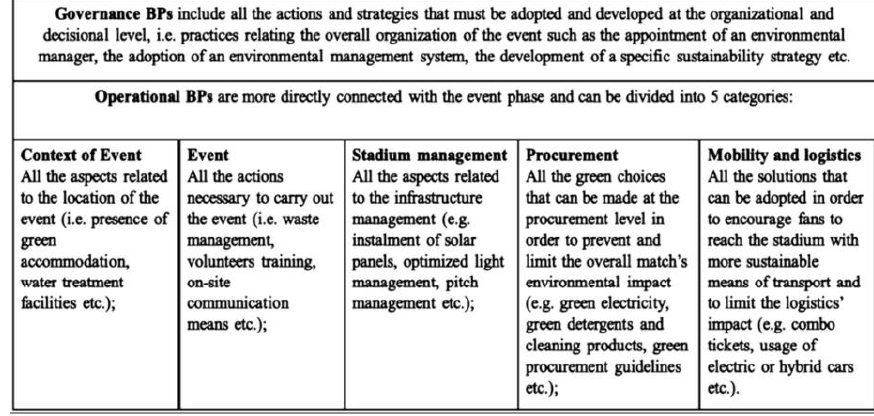
Fig. 1. Classification rationale into governance vs operational best practices Source: [19: p.